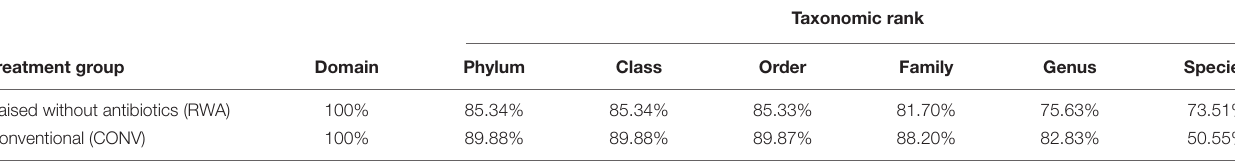
FIGURE 3 | Boxplot of resistome richness and Shannon’s diversity at the AMR class and mechanism levels of the two study groups, CONV vs RWA. The horizontal line is the median value, the middle box indicates the inter-quantile range, whiskers represent values within 1.5 IQR of the lower and upper quartiles, and individual points show outlier values. TABLE 1 | Table of the percentage of 16S rRNA sequencing reads classified taxonomically to each Linnaean level, by treatment group (CONV vs